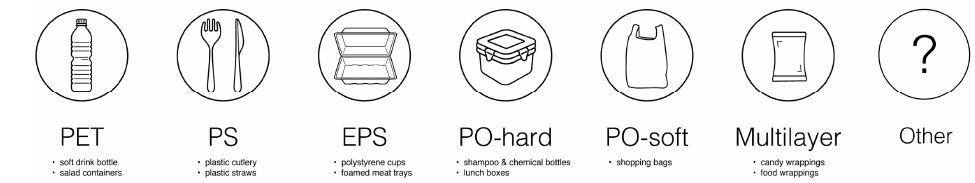
Figure 3. The categories used for classification in this research, including some typical items that belong to these classes. Items that cannot be identified as one of the six specific classes are categorized as “other”.